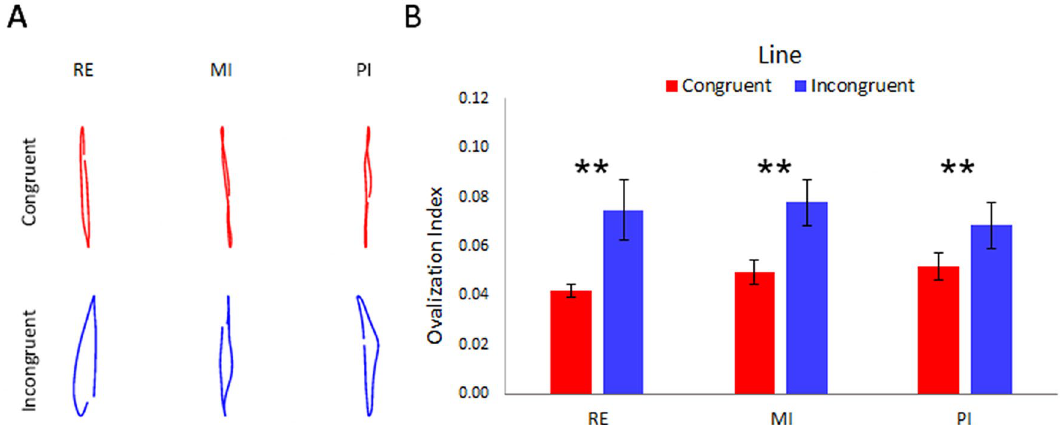
Figure 1. ( A ) Shows examples of a representative subject’s left-hand trajectory in the three protocols (Real - RE, Motor Imagery—MI and Proprioceptive Illusion—PI). Red lines represent the congruent condition (namely, when the subject was performing/imagining/perceiving lines with their right hand, too). Blue lines represent the incongruent condition (namely, when the subject was performing/imagining/perceiving circles with their right hand). The averaged Ovalization Indexes of the line-drawings performed with the left hand in RE, MI and PI protocols during congruent (red bar) and incongruent (blue bar) conditions are represented in ( B ). The error bars refer to the standard error of the mean. **Refers to t-test results of corrected p <